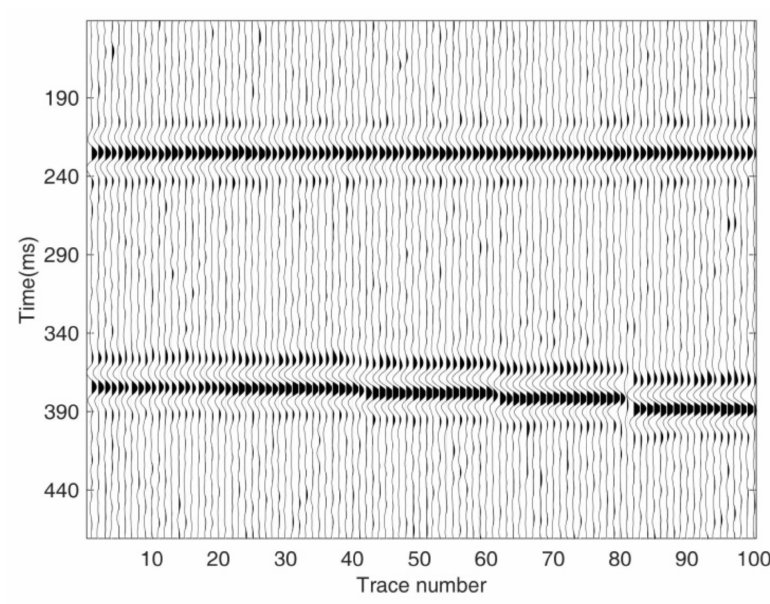
Figure 8. Synthetic seismogram with noise (after VMD denoising).